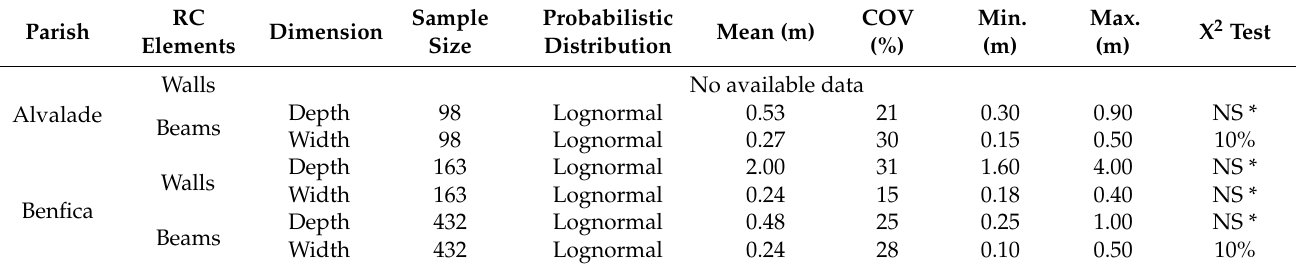
Table 9. Probabilistic distribution of RC walls and beams (cid:48) cross section for each